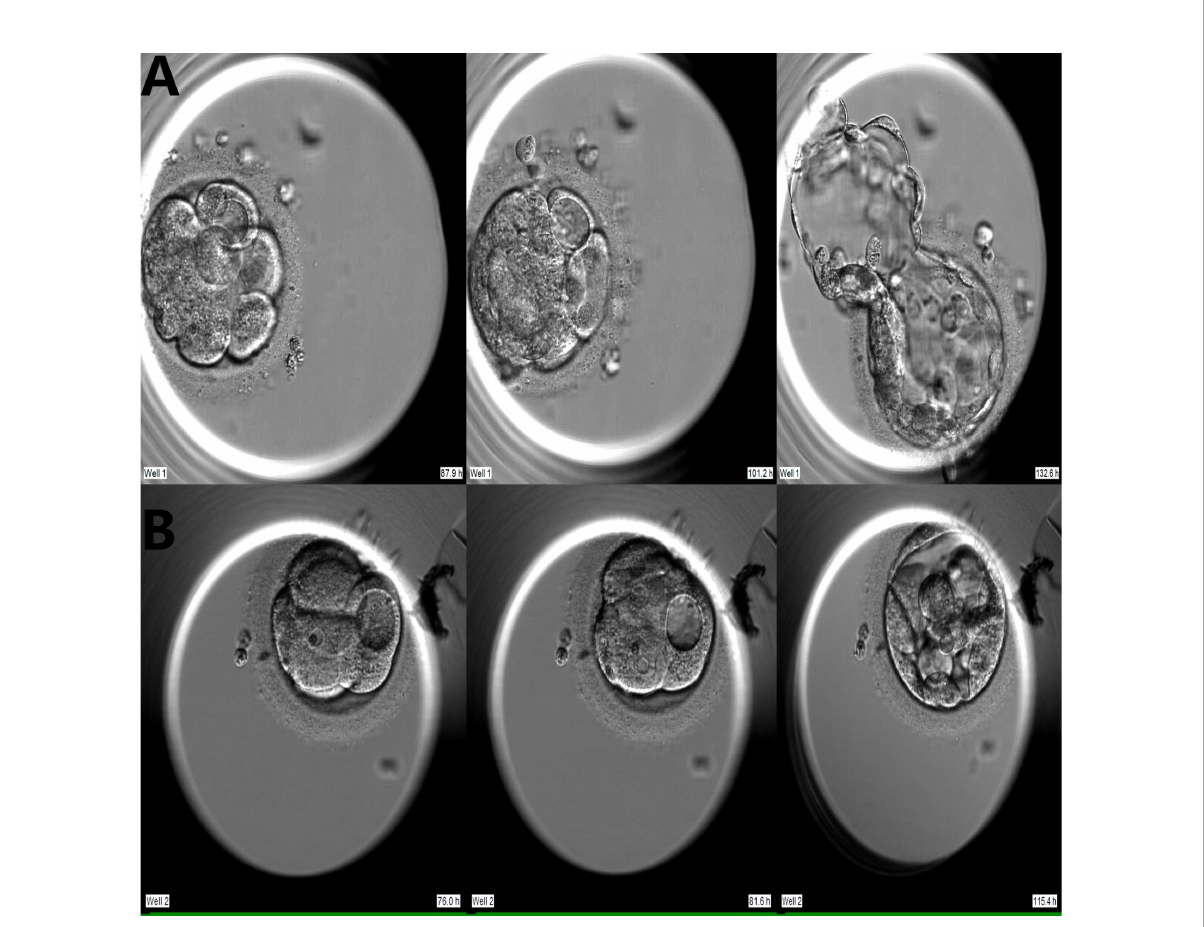
FIGURE 1 Two developmental models of vacuole-containing cells during embryo compaction. (A) Vacuole-containing cells that did not participate in compaction; (B) Vacuole-containing cells that participated in